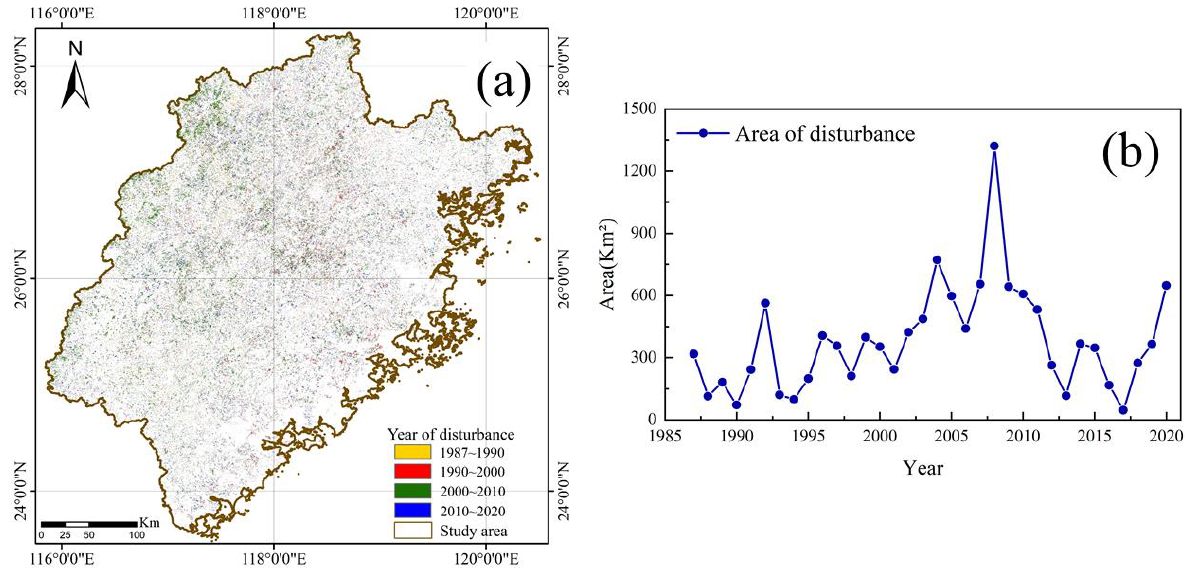
Figure 9. Time-series characteristics of forest disturbance in Fujian. ( a ) Disturbance years from 1987 to 2020. ( b ) Temporal characteristics of the forest disturbance area.